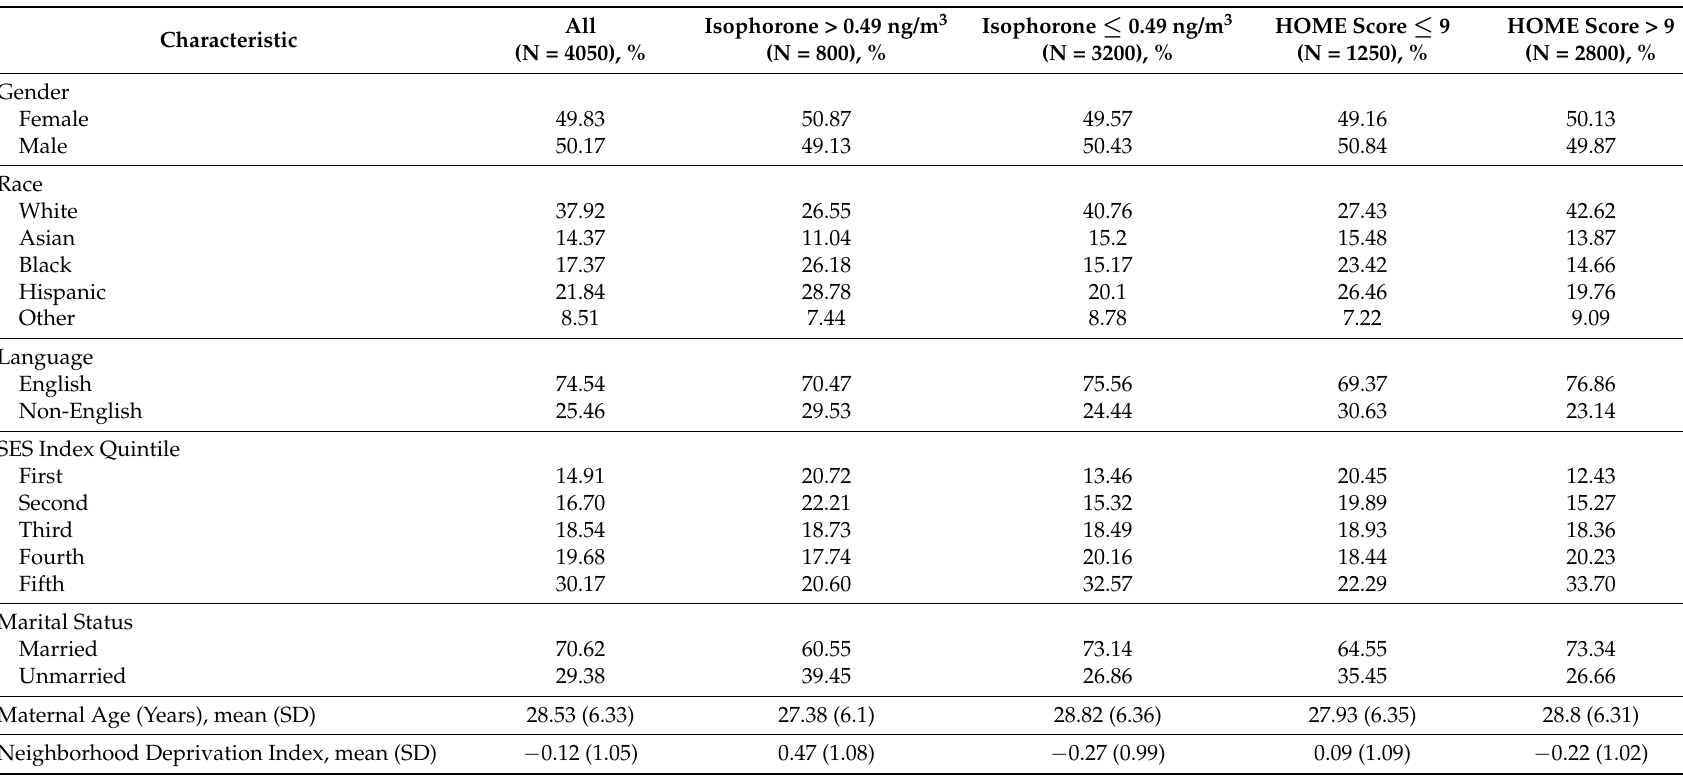
Table 1. Sociodemographic characteristics by level of exposure to isophorone in ambient air and Home Observation for Measurement of the Environment (HOME) Score among the subset of the Early Childhood Longitudinal-Study Birth cohort (ECLS-B) 2001 living in urban communities. SES = socioeconomic